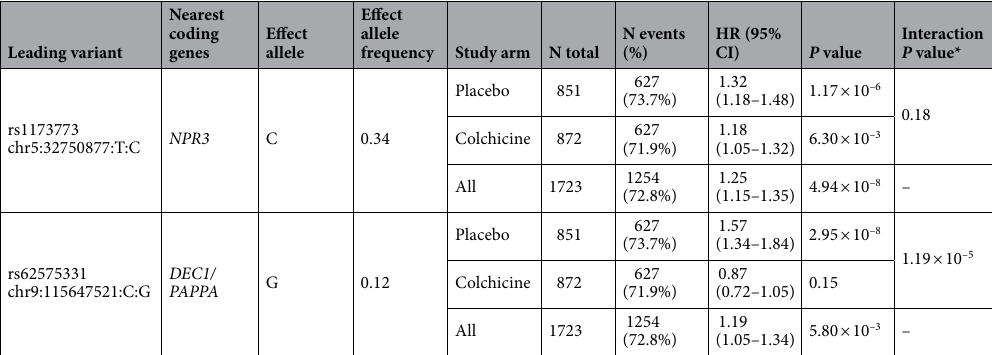
Table 2. Genetic association results of the leading genetic variants identified in the GWAS for time to COVID-19 symptom remission. Chr: chromosome; HR: hazard ratio; N: number of patients. Effect allele frequency in the study population. Reported results are for Cox proportional hazards regression adjusted for age, sex, and 10 principal components for genetic ancestry; and for the analysis of rs1173773, with additional adjustment for study arm. *Interaction P value for the variant by colchicine interaction term. Chromosomal positions are according to GRCh38.